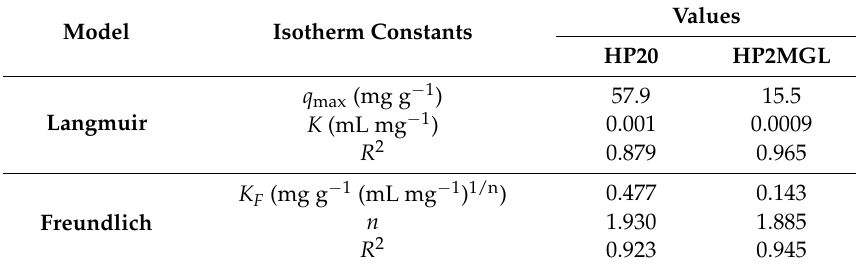
Table 2. Langmuir and Freundlich Parameters for the adsorption of SDBS Using HP20 and HP2MGL. Model